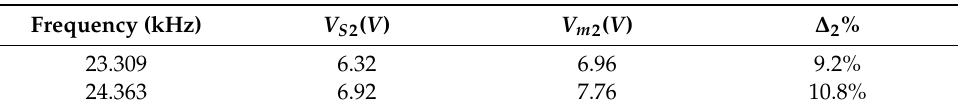
Table 7. The measured and simulated voltage values under the condition of the length for the transmission medium having 100